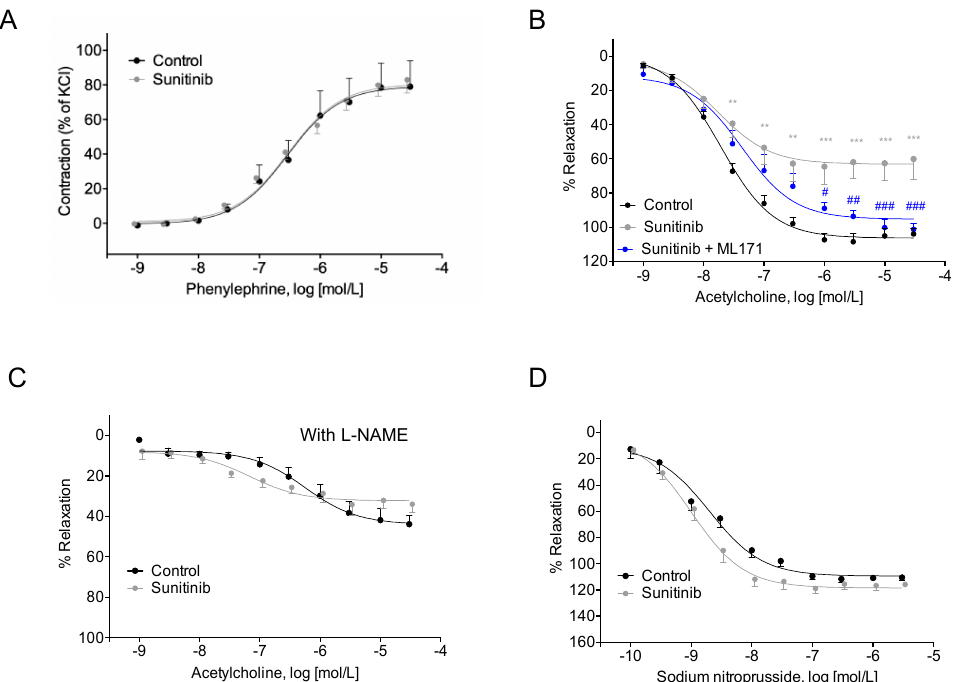
Figure 2. Dose-response curve of ( A ) vasoconstriction mediated by phenylephrine (Phe) (10 − 9 –3×10 − 5 mol/L); ( B ) ACh-mediated (10 − 9 –3×10 − 5 mol/L) vasodilation, including preincubation with ML171 (10 − 4 mol/L); ( C ) ACh-mediated vasodilation in the presence of L-NAME (N ω - nitro-L-arginine methyl ester (10 − 4 mol/L); and ( D ) vasorelaxation response to sodium nitroprusside (SNP) (10 − 10 –3×10 − 6 mol/L) in phenylephrine (Phe)-precontracted vessels from control and sunitinib-treated (25 mg/kg/day) animals. The results correspond to mean ± S.E.M. of at least six experiments ( n = 6–12). Results are expressed as relative percentages of the maximum contraction induced by 60 mmol/L KCl (A), or to the contraction induced by a submaximal dose of Phe (B–D). ** p < 0.01; *** p < 0.001 vs. control group, # p < 0.05, ## p < 0.01, ### p < 0.001 vs. Su group.